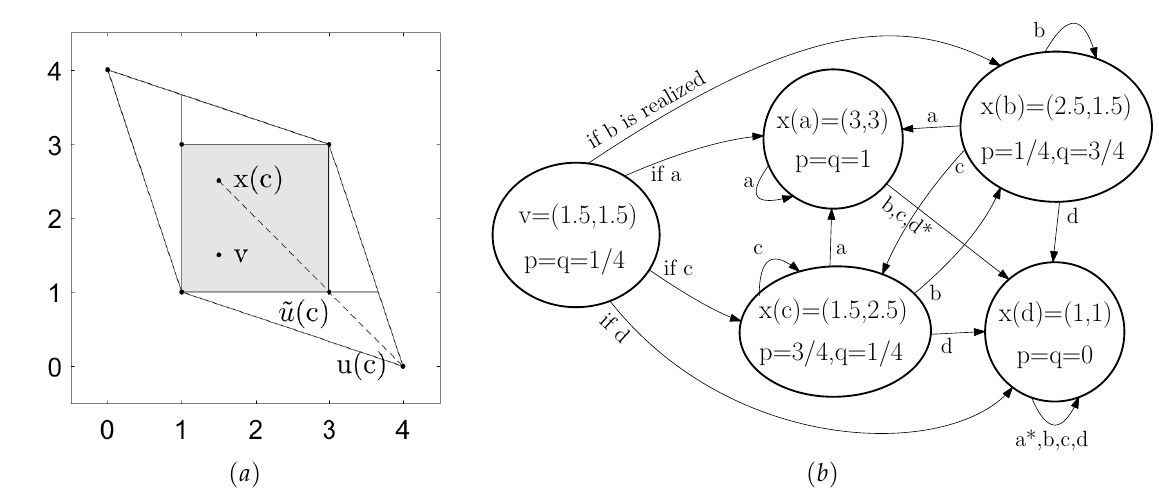
Figure 3. Geometric illustration of ( a ) a self-supporting set and ( b ) the strategies in game PD. The star ∗ denotes that the corresponding transition could be to any equilibrium